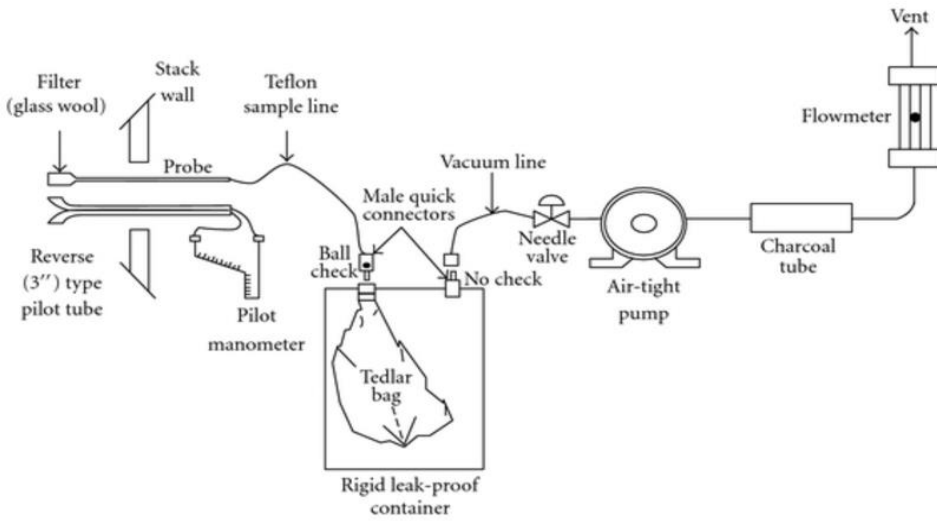
Figure 2. Periodic sampling using the lung sampler (EPA Method 18).